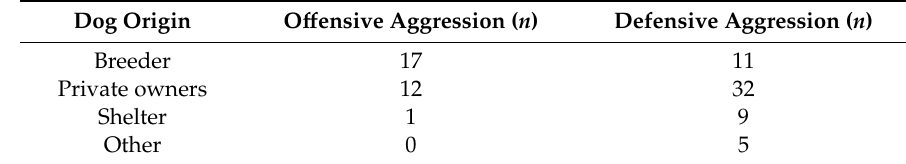
Table 14. Comparison of the type of dog–human aggression in dogs with di ff erent origins.